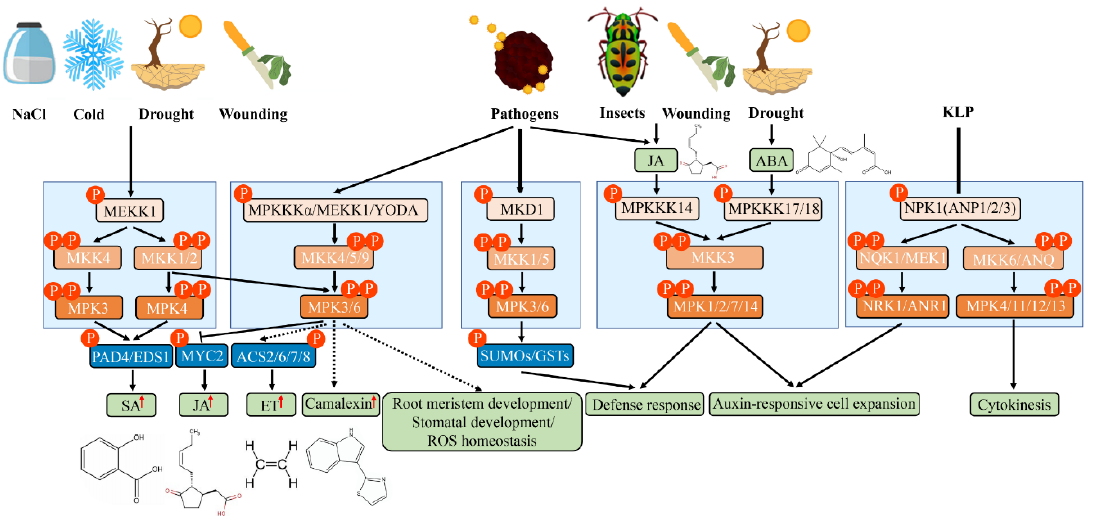
Figure 2. Overview of the functions of different MAPK cascades in stress responses as well as their regulation and possible downstream consequences. Upon sensing the tissue/cell-specific input signaling molecules, the MAPK cascade is activated in a spatiotemporal-specific manner. Activated MAPKs phosphorylate their substrate(s), ultimately leading to tissue-specific cell proliferation or differentiation at specific developmental stages or in response to specific external stimuli, thereby regulating plant growth, development, and stress responses. Arrows with uninterrupted lines indicate interactions supported by genetic and/or biochemical evidence, while arrows with dashed lines represent putative signaling pathways. One arrow may represent multiple steps because of unknown components in the signaling pathways. PAD4, Phytoalexin Deficient 4; EDS1, Enhanced Disease Susceptibility 1; ACS, 1-aminocyclopropane-1-carboxylic acid synthase; MKD1, MAPKKK δ -1; SUMO, small ubiquitin-like modifier; GST, glutathione S-transferase; ROS, reactive oxygen species; KLP, kinesin-like protein; NPK1, nucleus- and phragmoplast-localized protein kinase 1; ANP, Arabidopsis NPK1-related protein kinases; SA, salicylic acid; JA, jasmonic acid; ET, ethylene; ABA, abscisic acid. See text for details.